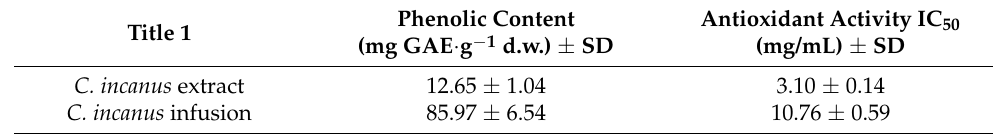
Table 1. TPC and antioxidant capacity of a C. incanus extract and